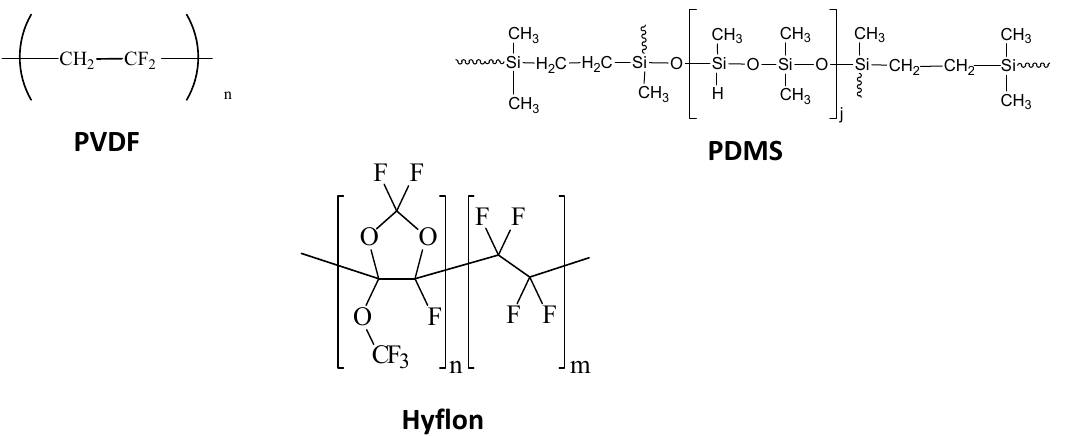
Figure 7. Chemical formula of the polymers used as membrane materials for the heterogenization of polyoxometalates.